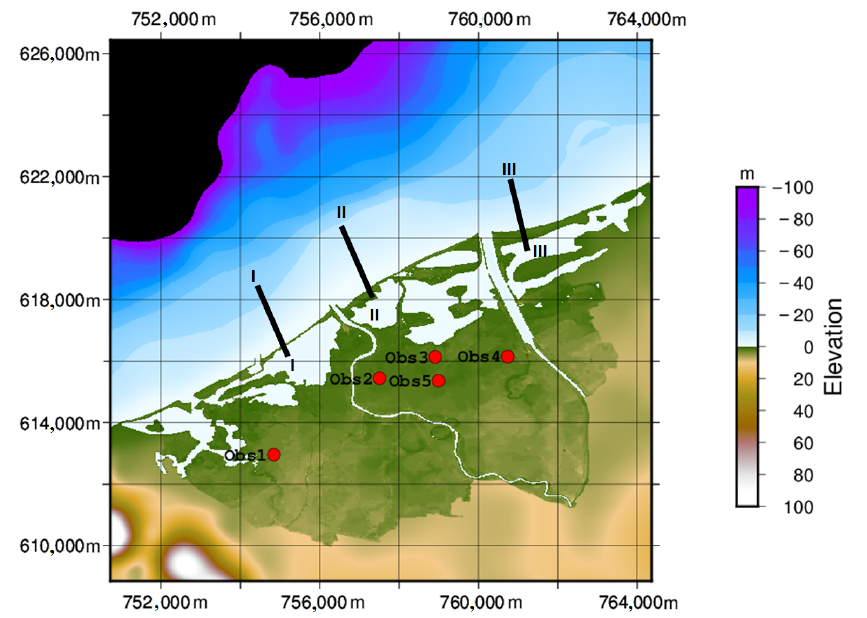
Figure 5. Locations of the numerical observation points and